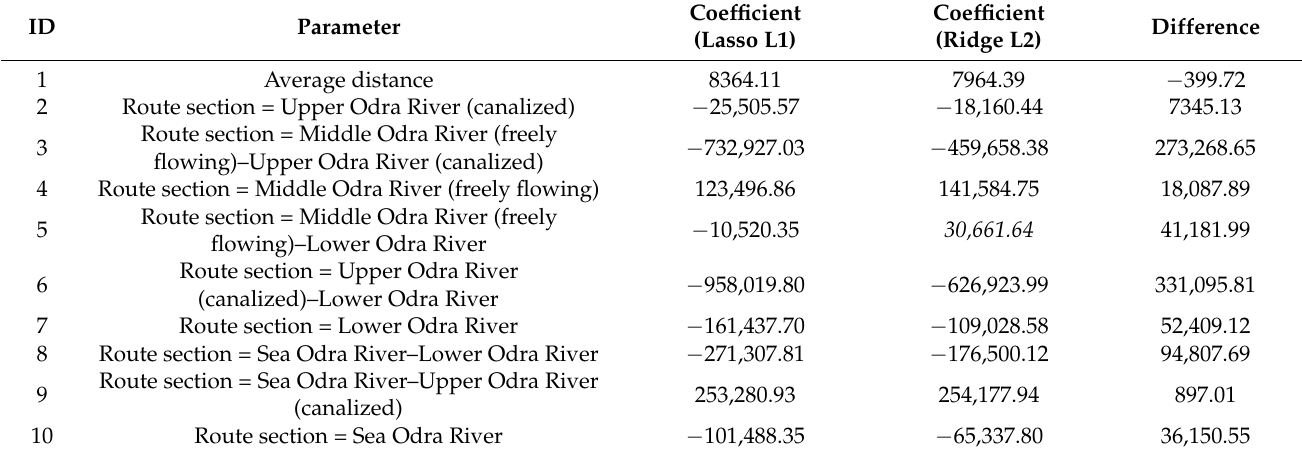
Table 9. Regularized warming model of energy intensity in inland waterway freight transport in relation to the selection of route section and the average distance traveled by 1 ton of goods by Lasso and Ridge